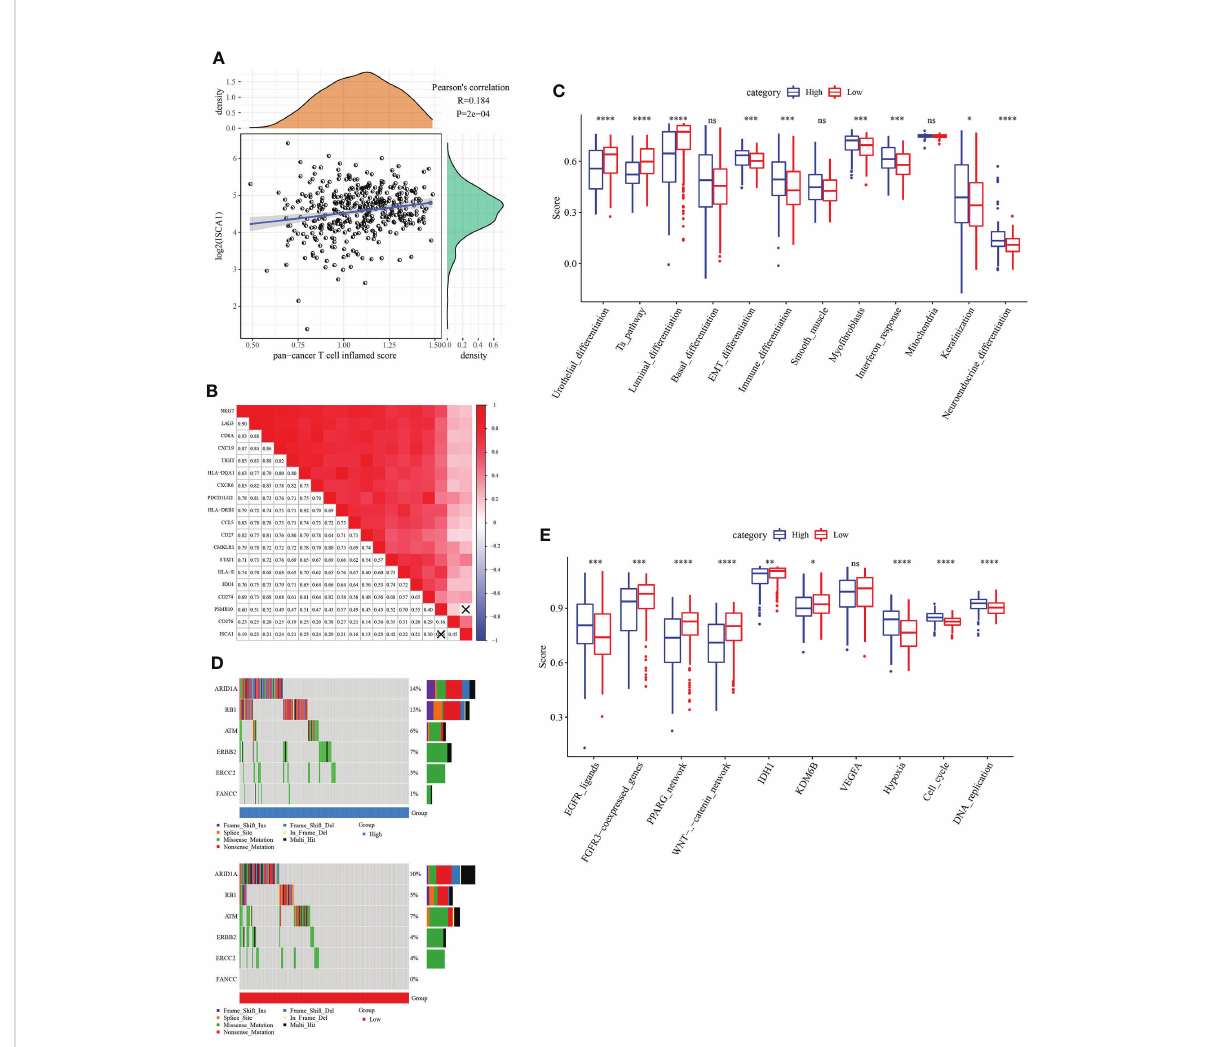
FIGURE 6 The immune characteristic analysis of ISCA. (A, B) Correlation between ISCA1 and pan-cancer T cell in fl ammation score, and correlation between individual genes contained in T cell in fl ammation characteristics. The score of T cell in fl ammation was positively correlated with the clinical response to cancer immunotherapy. (C) Correlation between ISCA1 and molecular subtypes and BLCA characteristics using seven different algorithms. (D) Mutation spectrum of neoadjuvant chemotherapy-related genes in low ISCA1 group and high ISCA1 group. (E) Correlation between ISCA1 and enrichment scores of several therapeutic features such as targeted therapy and radiotherapy. *P<0.05, **P<0.01, ***P<0.001, ****P<0.0001,